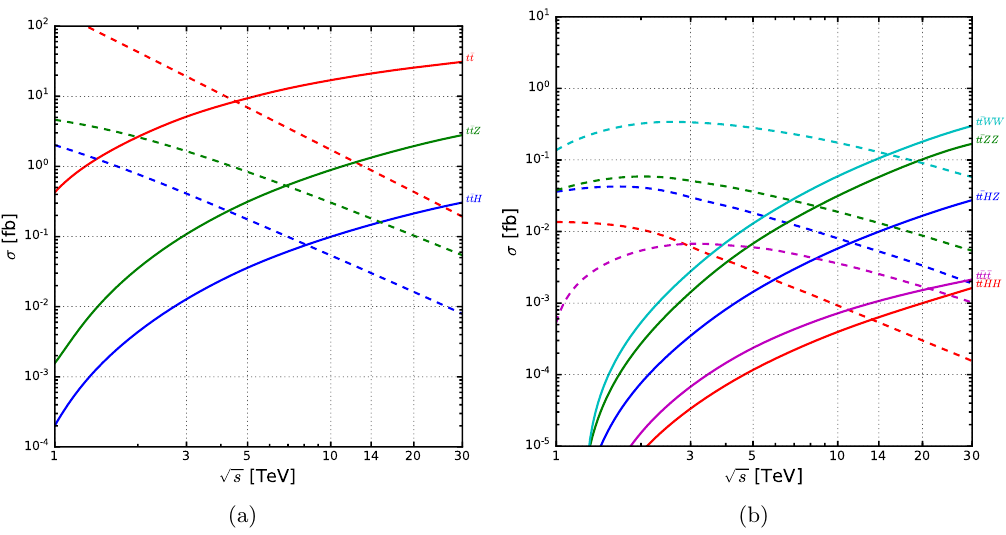
Figure 3 . W + W (cid:0) fusion (solid) and analogous s -channel annihilation (dashed) cross sections (cid:27) [fb] for (a) ttX and (b) ttXX associated production as a function of collider energy